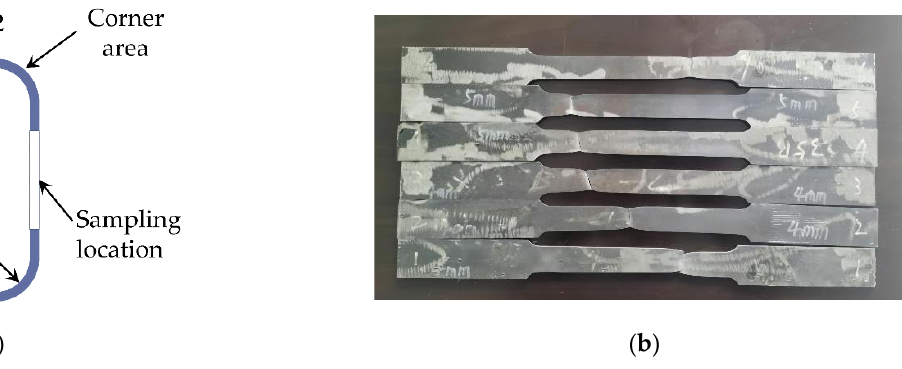
Figure 4. Tensile test ( a ) sampling location; ( b ) samples.